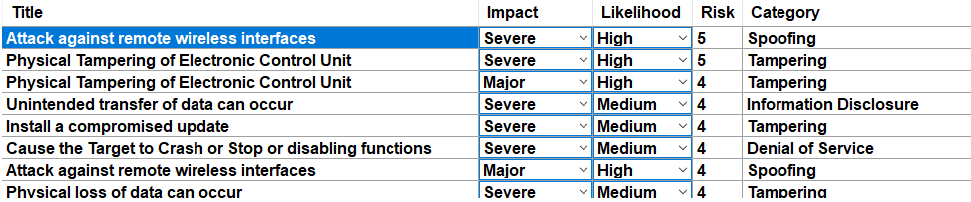
Figure 17. Excerpt of the threat catalog after updating security